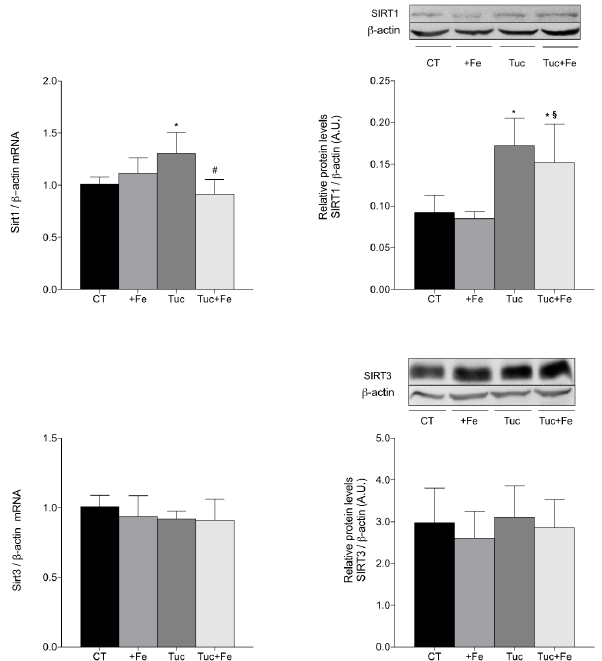
Figure 5. Hepatic mRNA quantification of Sirt1 and Sirt3 and protein levels determination of SIRT1 and SIRT3 in liver of adult rats treated for 12 weeks. Data correspond to average ± standard deviation ( n = 6 ). * Statistical differences compared to CT group ( p < 0.05). § Statistical difference compared to +Fe group ( p < 0.05). # Statistical difference compared to Tuc group ( p < 0.05).